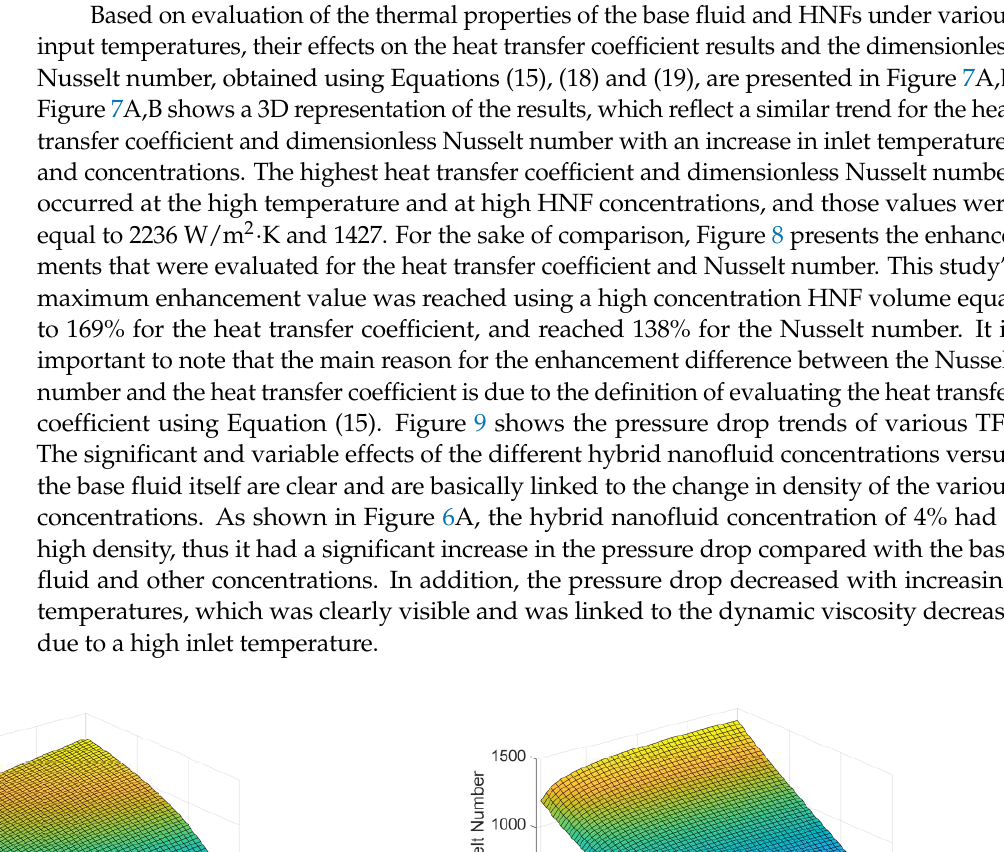
Figure 6. Thermal properties versus temperatures for base fluid and HNFs. ( A ) Density and dynamic viscosity; ( B ) thermal conductivity and specific heat capacity.